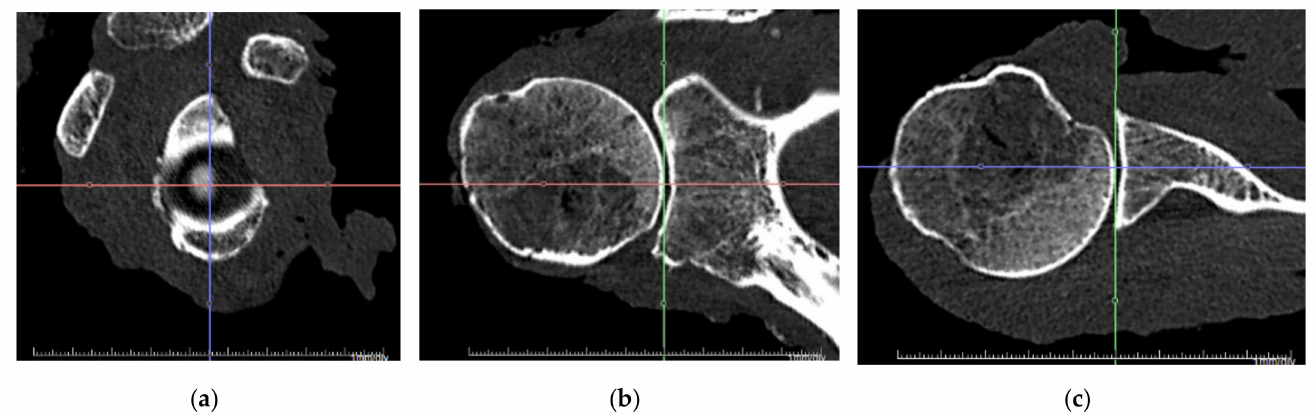
Figure 2. Alignment of joint-specific coordinate system. The superoinferior and anteroposterior axes were aligned with the long and short axes of the glenoid, respectively. The mediolateral axis results orthogonal to the others: ( a ) sagittal view; ( b ) coronal view; ( c ) transversal